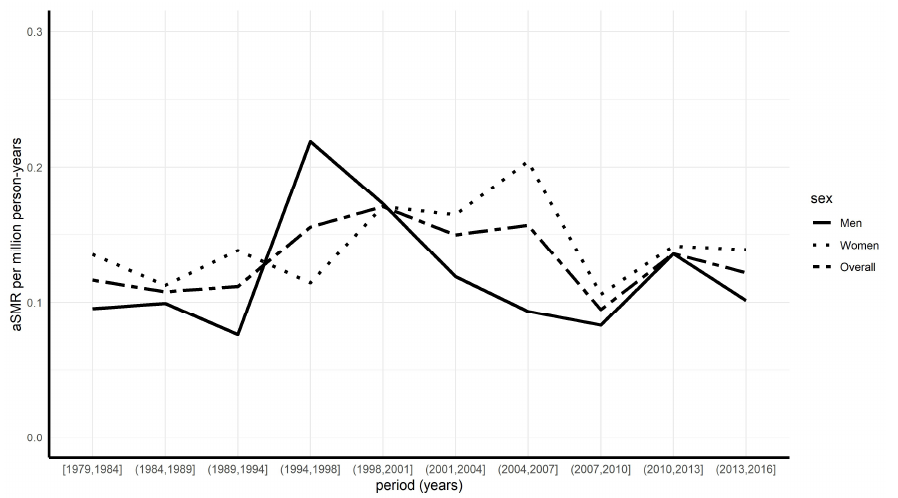
Figure 2. Evolution of the age-standardized mortality rate (aSMR) during the period 1979 to 2016 according to periods of time and modeling. The time periods were set in a way to ensure a homogeneous distribution of cases in the intervals.